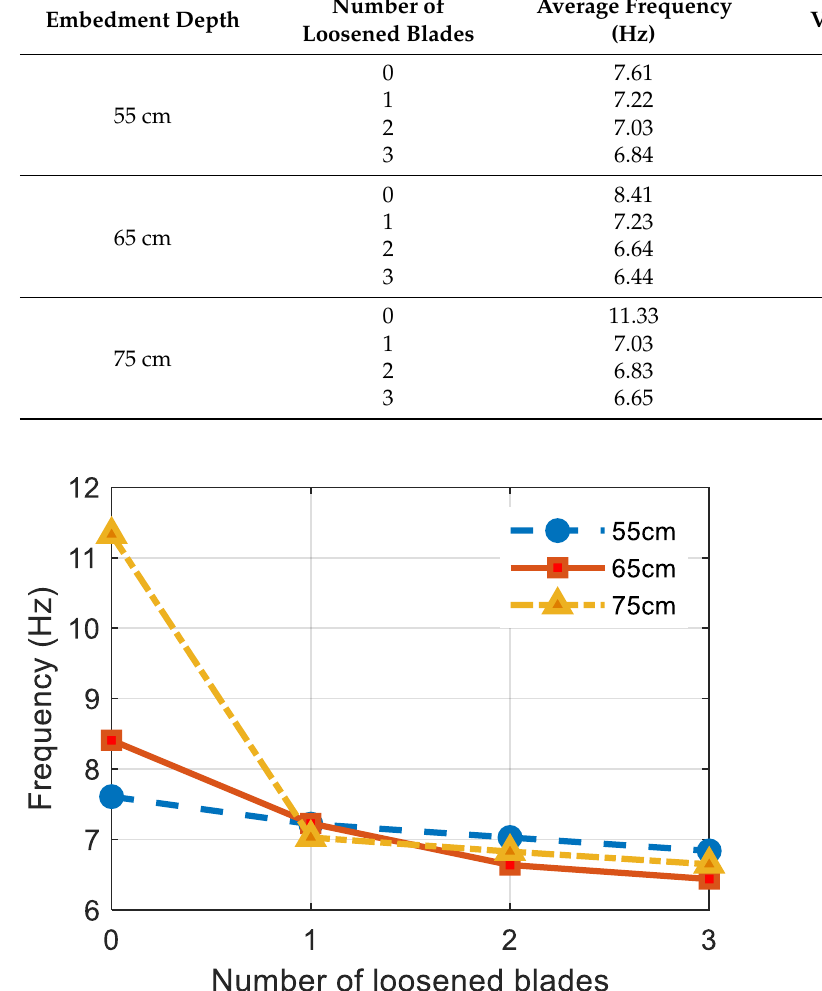
Figure 9. Frequency of the OWT with loosened